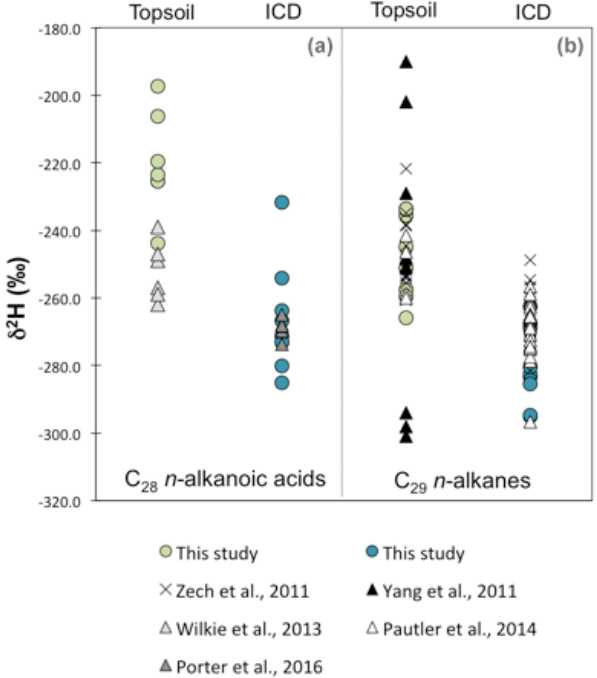
Figure 5. Comparison of δ 2 H values of C 28 n -alkanoic acid (a) and C 29 n -alkane (b) in modern topsoil PF (green circles) and ICD PF for this study (blue circles) and available literature, with crosses from Zech et al. (2011; glacial and interglacial paleosols from per- mafrost bluff exposure at Tumara River northeast Siberia), black triangles from Yang et al. (2011; C3 plants and trees from Canada and Alaska), light grey triangles from Wilkie et al. (2013; C3 plants from the El’gygytgyn lake basin, Siberia), white triangles from Pautler et al. (2014; modern and paleosols from Yukon, Canada) and dark grey triangles from Porter et al. (2016; muck deposits from Yukon,